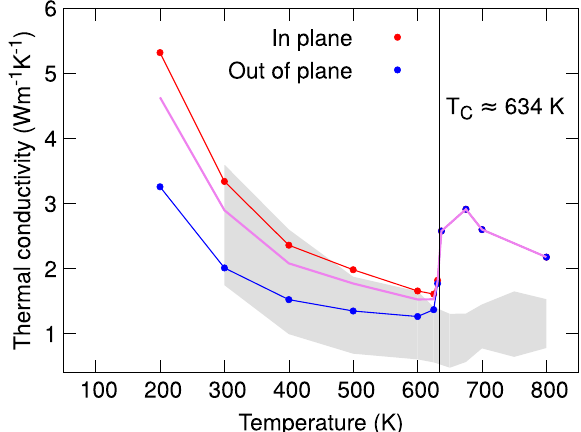
Fig. 4 Temperature dependence of the lattice thermal conductiv- ity of GeTe. Red and blue lines represent the calculated values using the Boltzmann transport approach in the directions perpendicular and parallel to the trigonal [111] axis, respectively. The purple line represents the average values of the computed lattice thermal conductivity. The grey region represents the experimental results collected from refs. 25 – 32